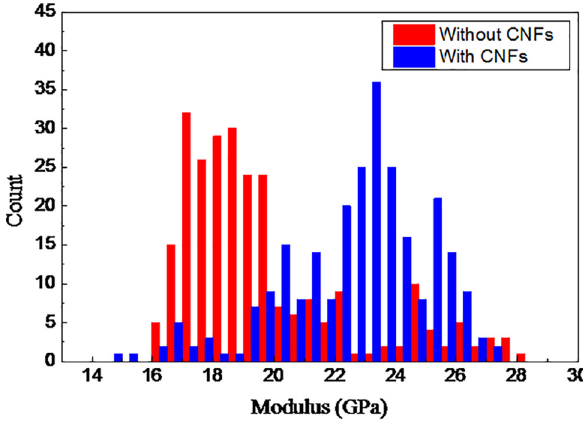
Figure 11: Elastic modulus of ITZ modi fi ed by CNFs [ 117 ]